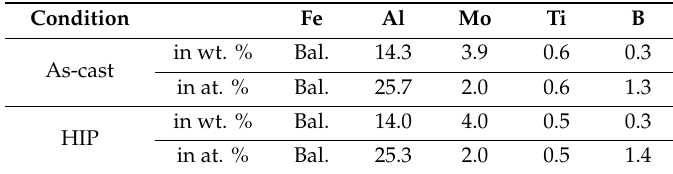
Table 1. Measured chemical compositions of the Fe-Al-Mo-Ti-B alloy processed via casting or hot isostatic pressing (HIP). Condition Fe Al Mo Ti B in wt. As-cast